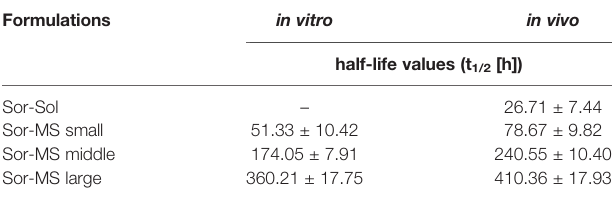
half-life values (t 1/2 [h])